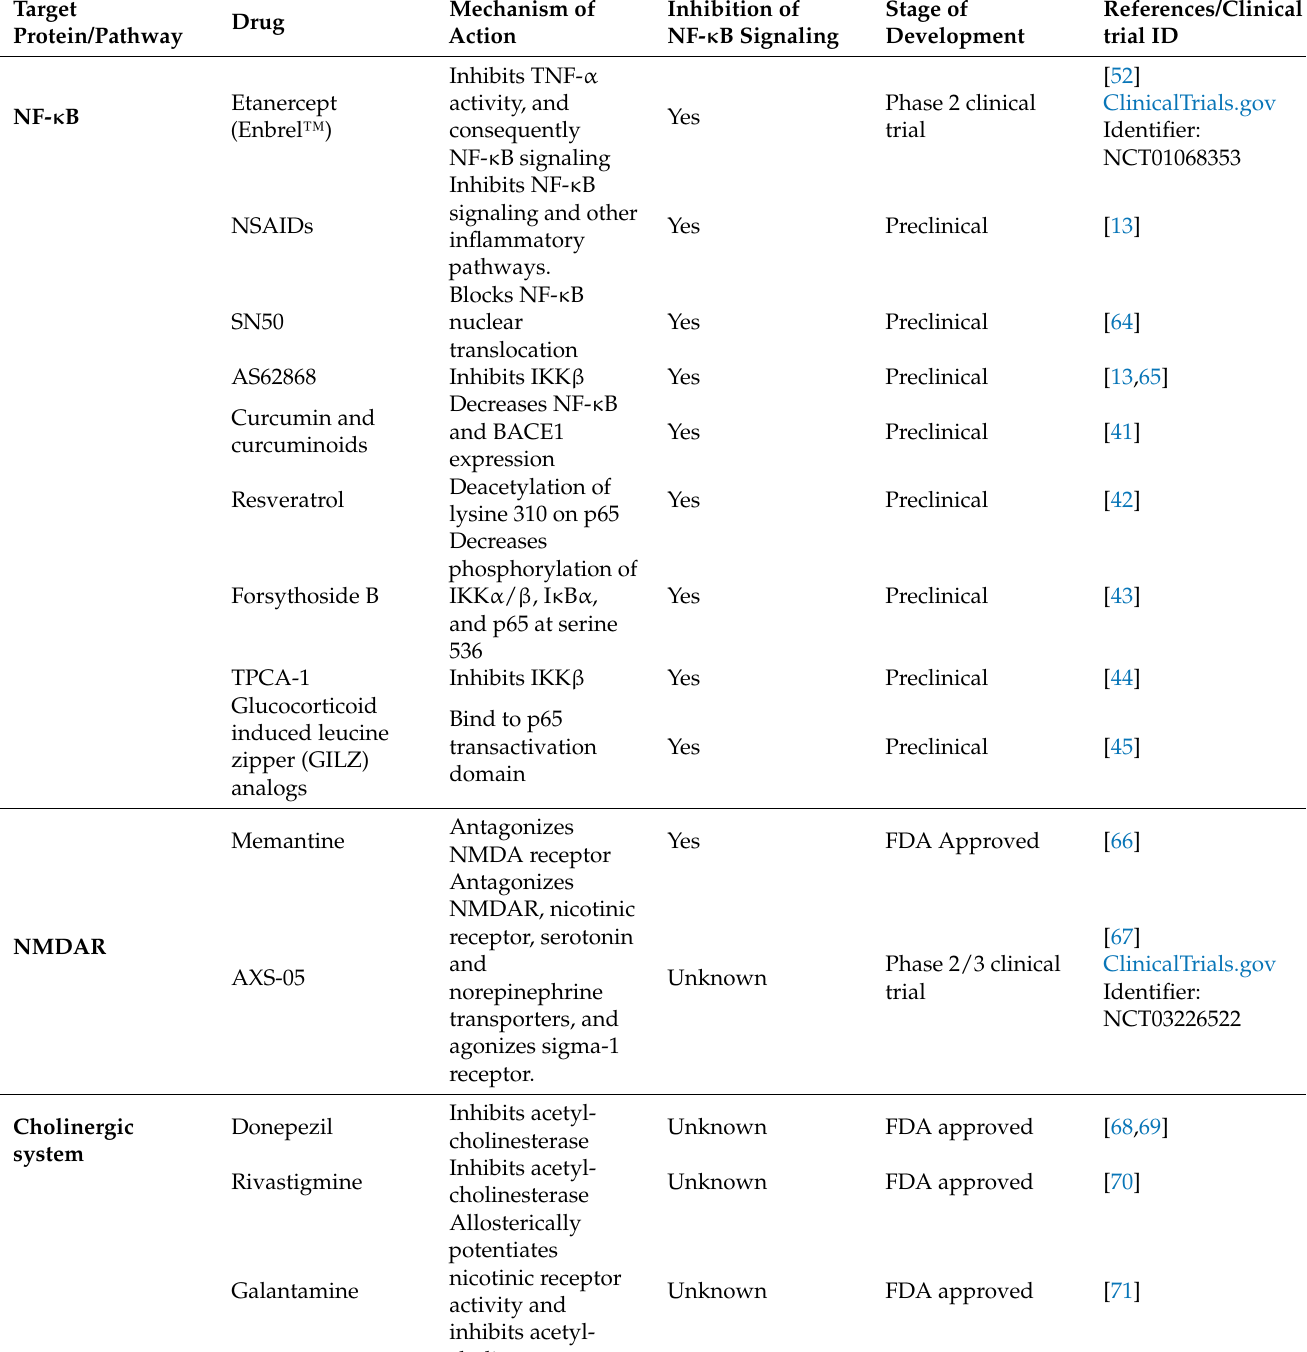
Table 1. An overview of the drug development landscape for